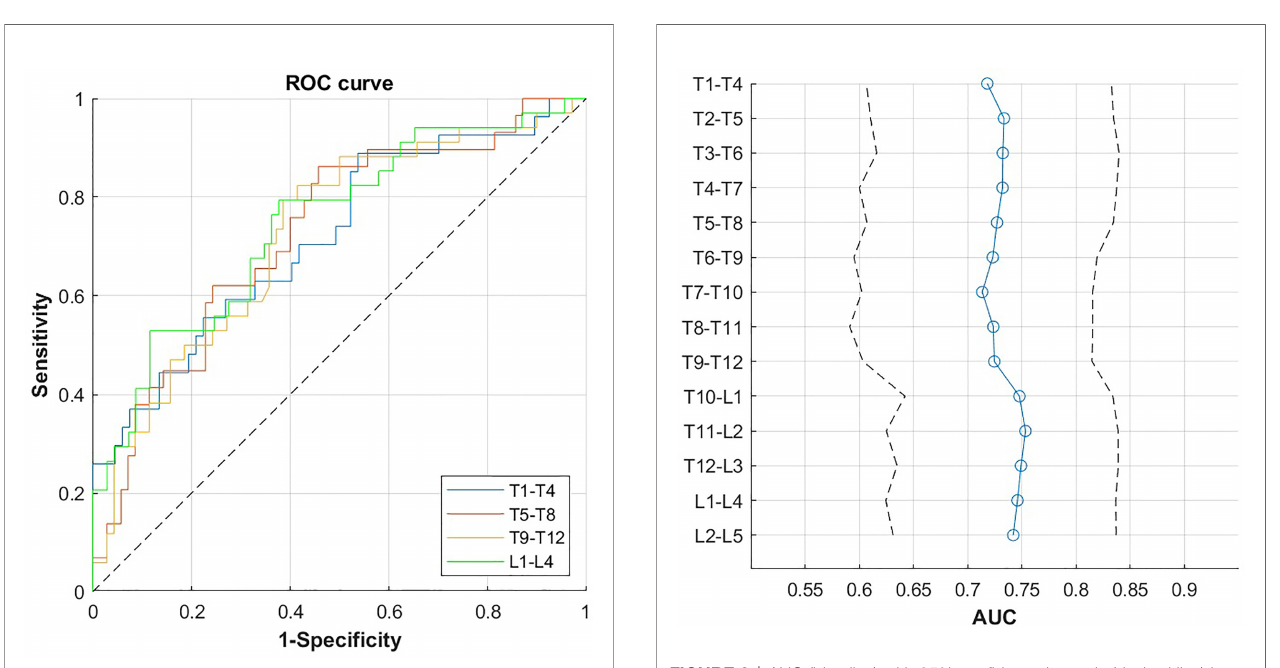
FIGURE 2 | ROC curves for the prediction of incident VF by volumetric bone mineral density (vBMD) for the combination of four consecutive vertebral bodies of the thoracolumbar spine. ROC, receiver operating characteristics; VF, vertebral fracture.